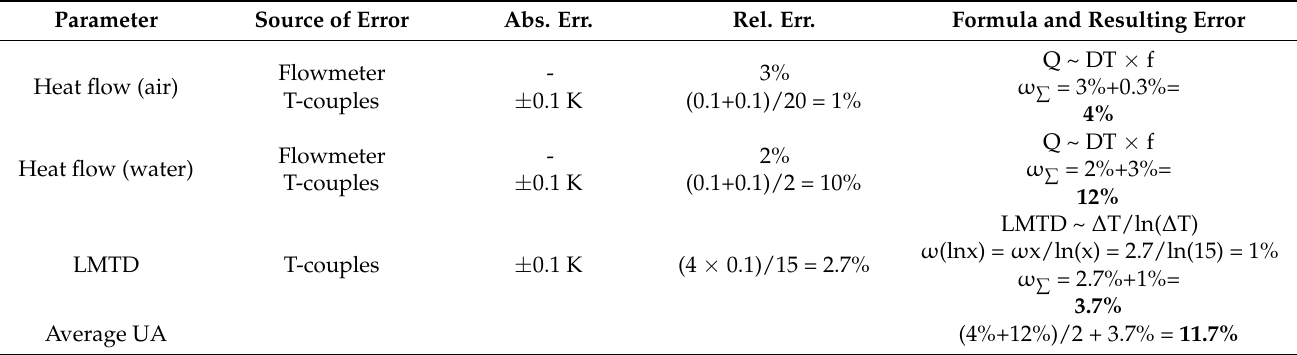
Table 2. Sources of experimental errors and error